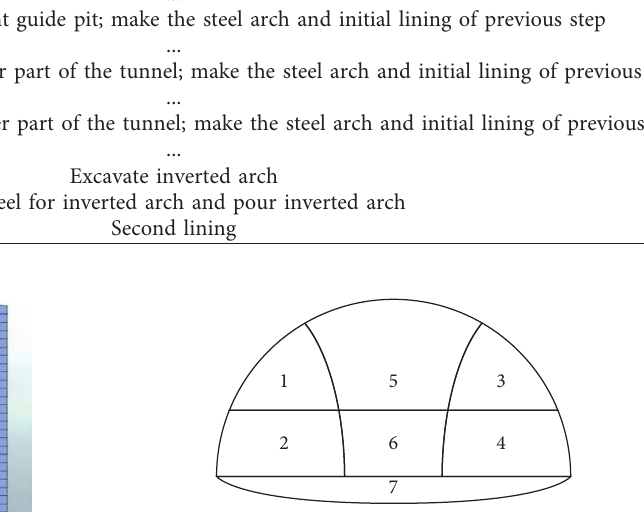
Figure 5: Construction sketch of the double-side guide pit method (1: the upper part of the left guide pit; 2: the lower part of the left guide pit; 3: the upper part of the right guide pit; 4: the lower part of the right guide pit; 5: the upper middle part; 6: the lower middle part; 7: the inverted